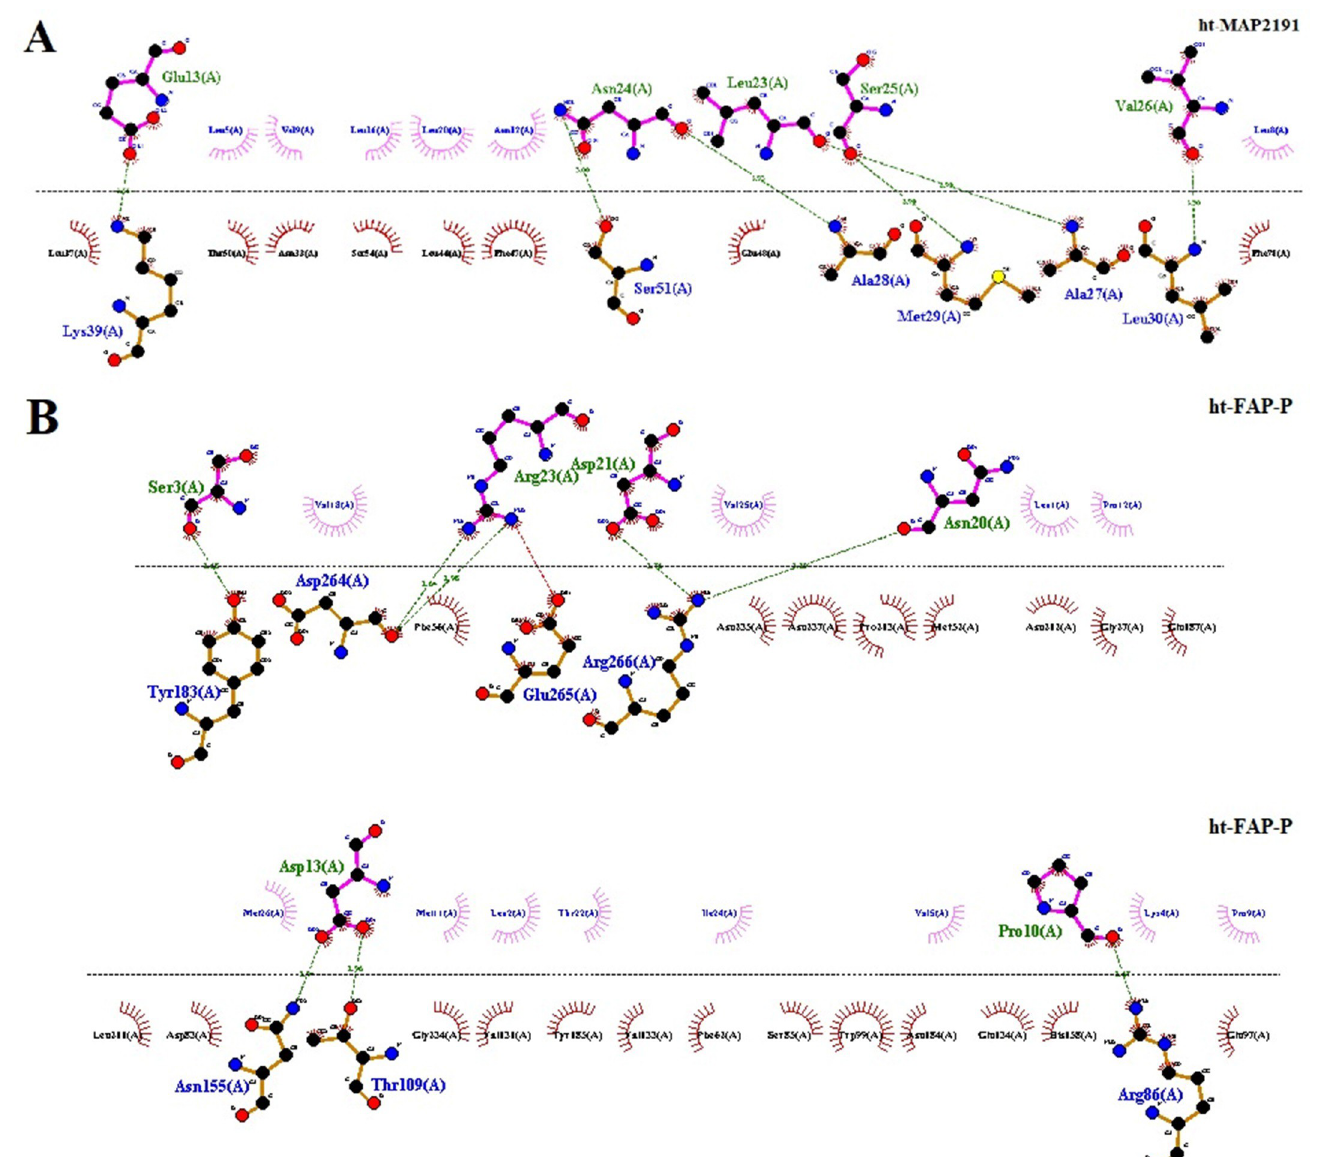
Fig 7. The map of interactions between ligands and TLR4. A) ht-Map2191 and B) ht-FAP-P. Green dotted lines represent hydrogen bonds.